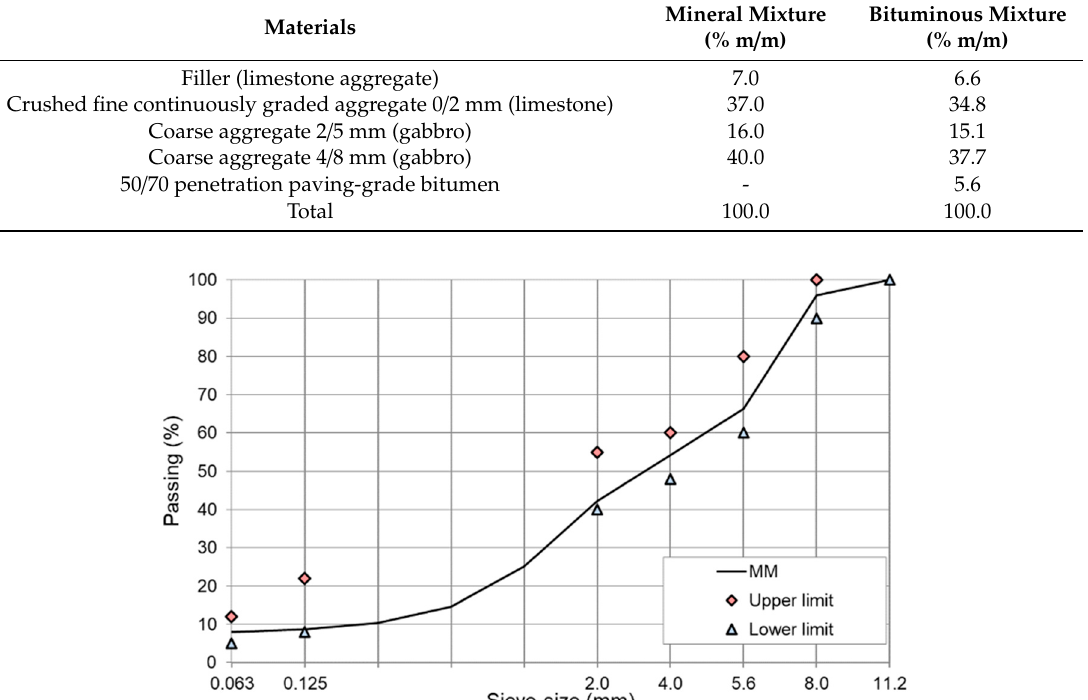
Figure 3. Experimental design [72].